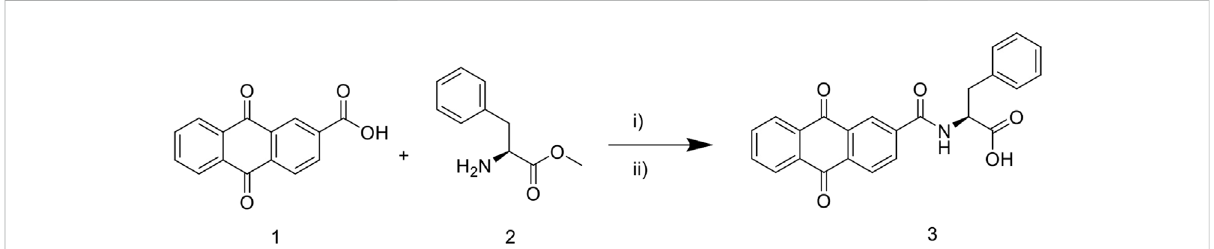
FIGURE 1 Synthetic route of 9, 10 — anthraquinone XOD inhibitor. Scheme 1: reagents and conditions: i) EDCI, HOBt, CH 2 Cl 2 , 25 ° C, overnight; ii) MeOH/ THF, NaOH, 50 ° C, 4 h; 10% HCl, pH